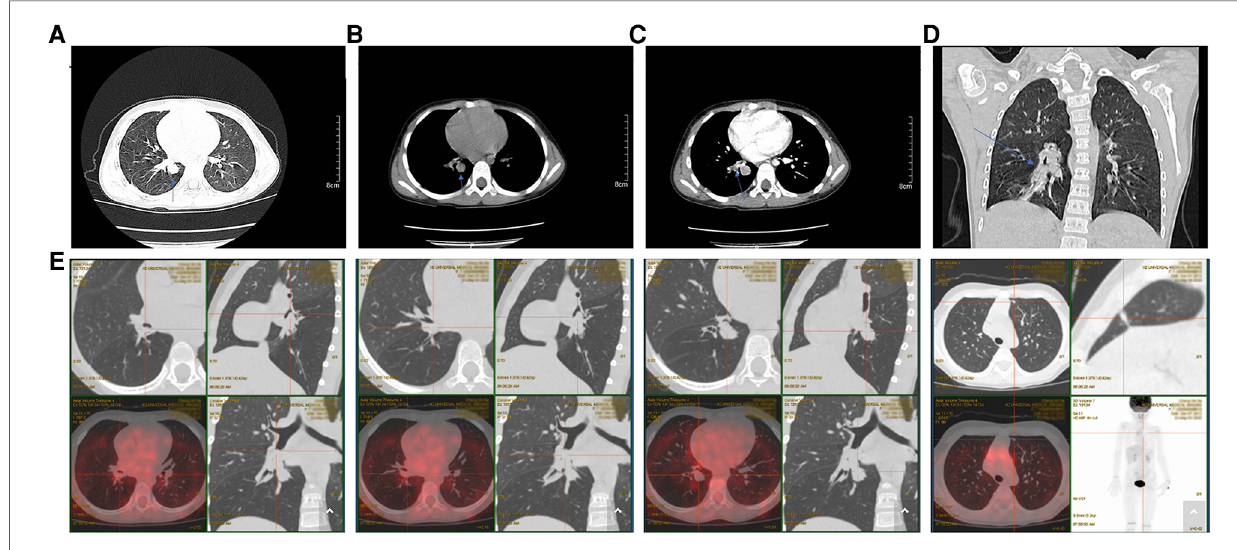
FIGURE 1 ( A ) A round mass in the right lower lobe adjacent to the bronchus, with a well-de fi ned boundary and thickened adjacent lung texture (blue arrow). ( B ) A mediastinal window on the same plane as the image above shows a round soft tissue mass adjacent to the bronchus in the lower lobe of the right lung, with a well-de fi ned boundary and thickened adjacent lung texture (blue arrow). ( C ) Contrast-enhanced mediastinal window scan on the same plane shows obvious enhancement of a round soft tissue mass adjacent to the bronchus in the lower lobe of the right lung, with uniform enhancement, a well-de fi ned boundary, no burr or satellite foci, and an irregular soft tissue mass near the lung texture (blue arrow). ( D ) Coronal reconstruction, showing irregular density shadow in the lower lobe of the right lung with a well-de fi ned boundary, surrounding the bronchial branches of the lower lobe. ( E ) PET-CT: soft tissue mass in the right middle bronchus, the right lower lobe bronchus, the basal trunk, and the medial basal segmental bronchus, along with elevated FDG metabolism and combined with pathology results, this led soft tissue sarcoma to be considered. FDG: